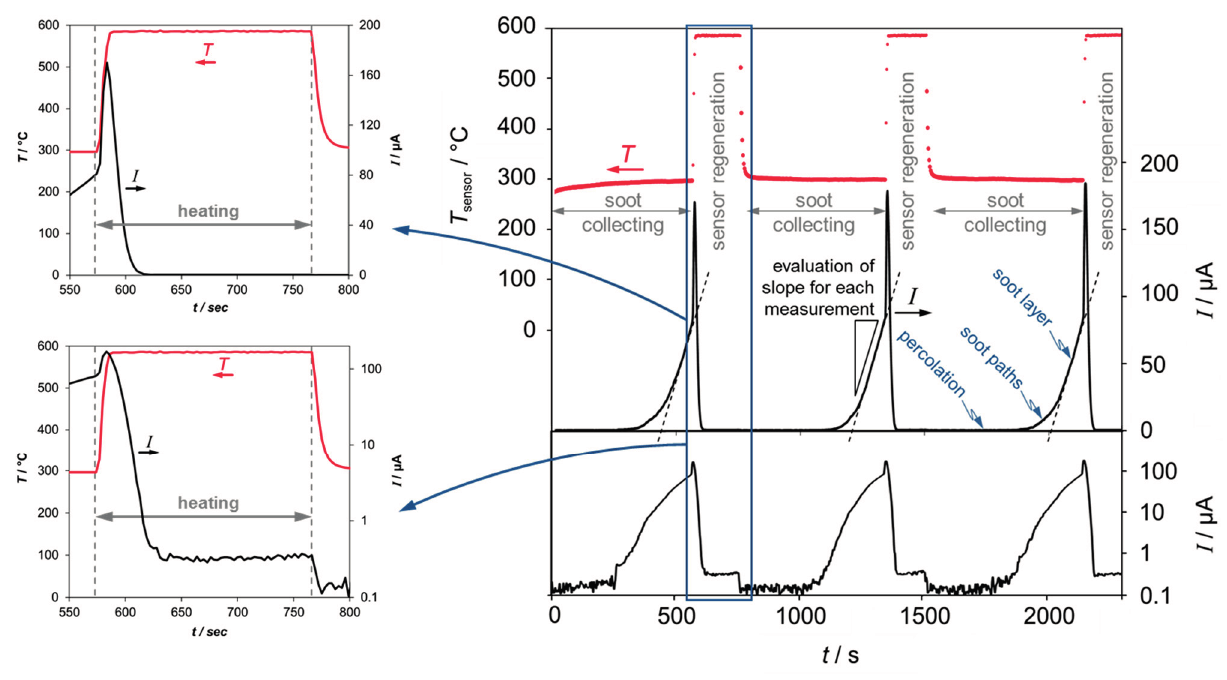
Figure 2. Typical raw data of the current I (at constant operation conditions) plotted linearly (right, upper graph) as well as logarithmically (right, lower graph). During soot collection, the sensor current I increases constantly. The evaluation of the current gradient s (slope d I /d t )